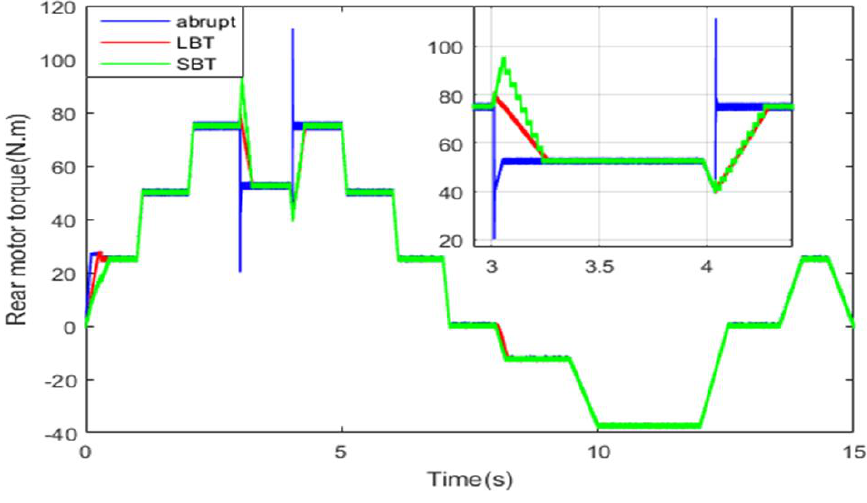
Figure 23. Rear motor torque. Table 5. Torque ripples using all transition functions.